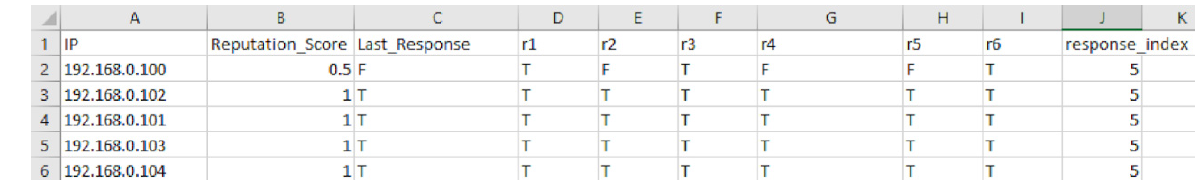
Figure 16. Markov model example diagram.